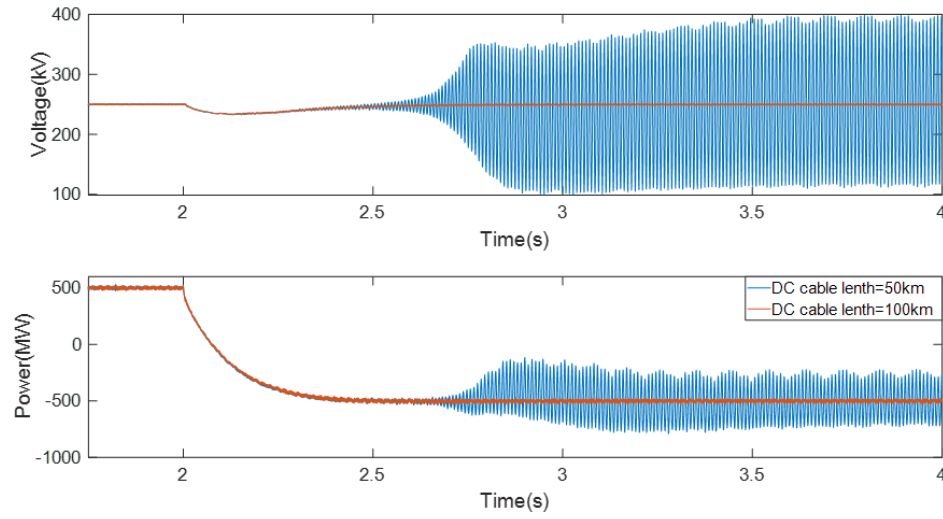
Figure 14. DC-link voltage and active power of the VSC – HVDC system under different DC cable lengths.